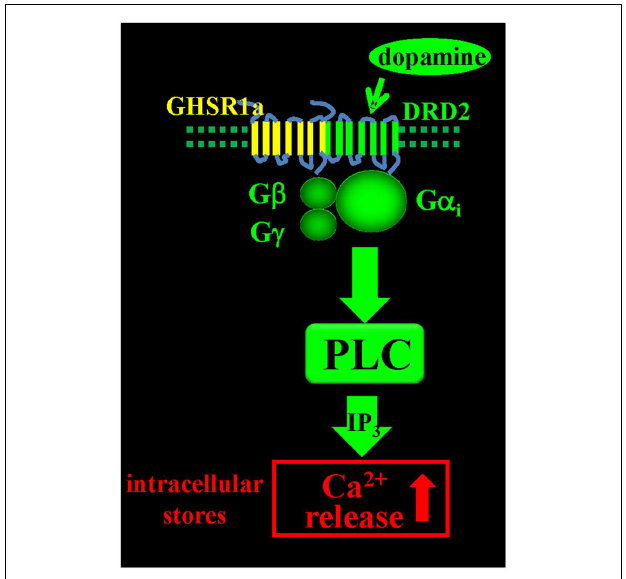
FIGURE 1 | Dopamine-induced [Ca 2 + ] i mobilization via GHSR1a:DRD2 heteromers . Dopamine activation of GHSR1a:DRD2 causes release of Ca 2 + from intracellular stores by G βγ dependent PLC activation and mobilization of IP